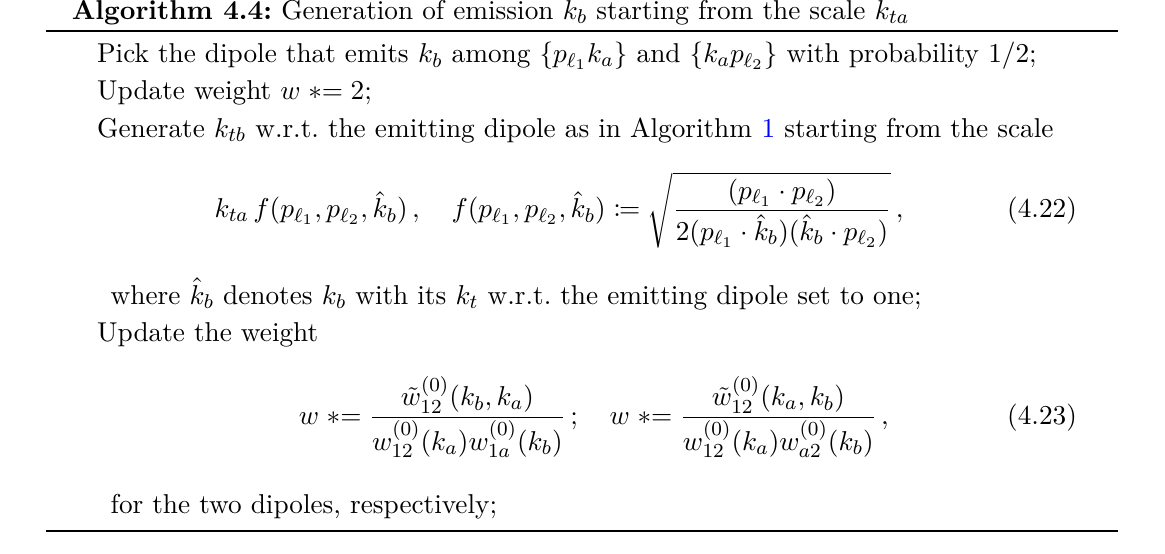
starting from the scale k b